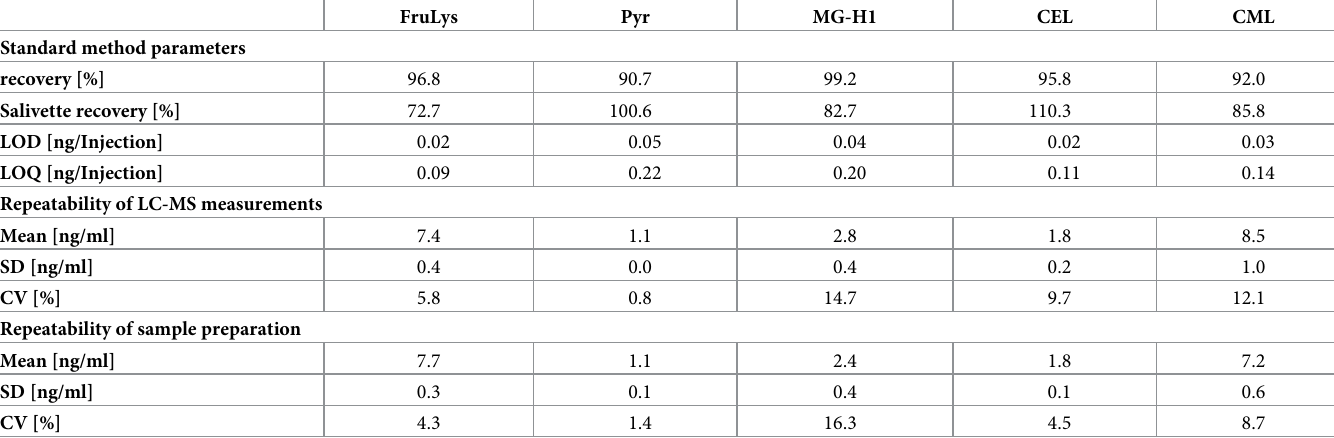
Table 2. Performance and validation parameters of the LC-MS/MS method for the quantitation of (glycated) amino acids in saliva.